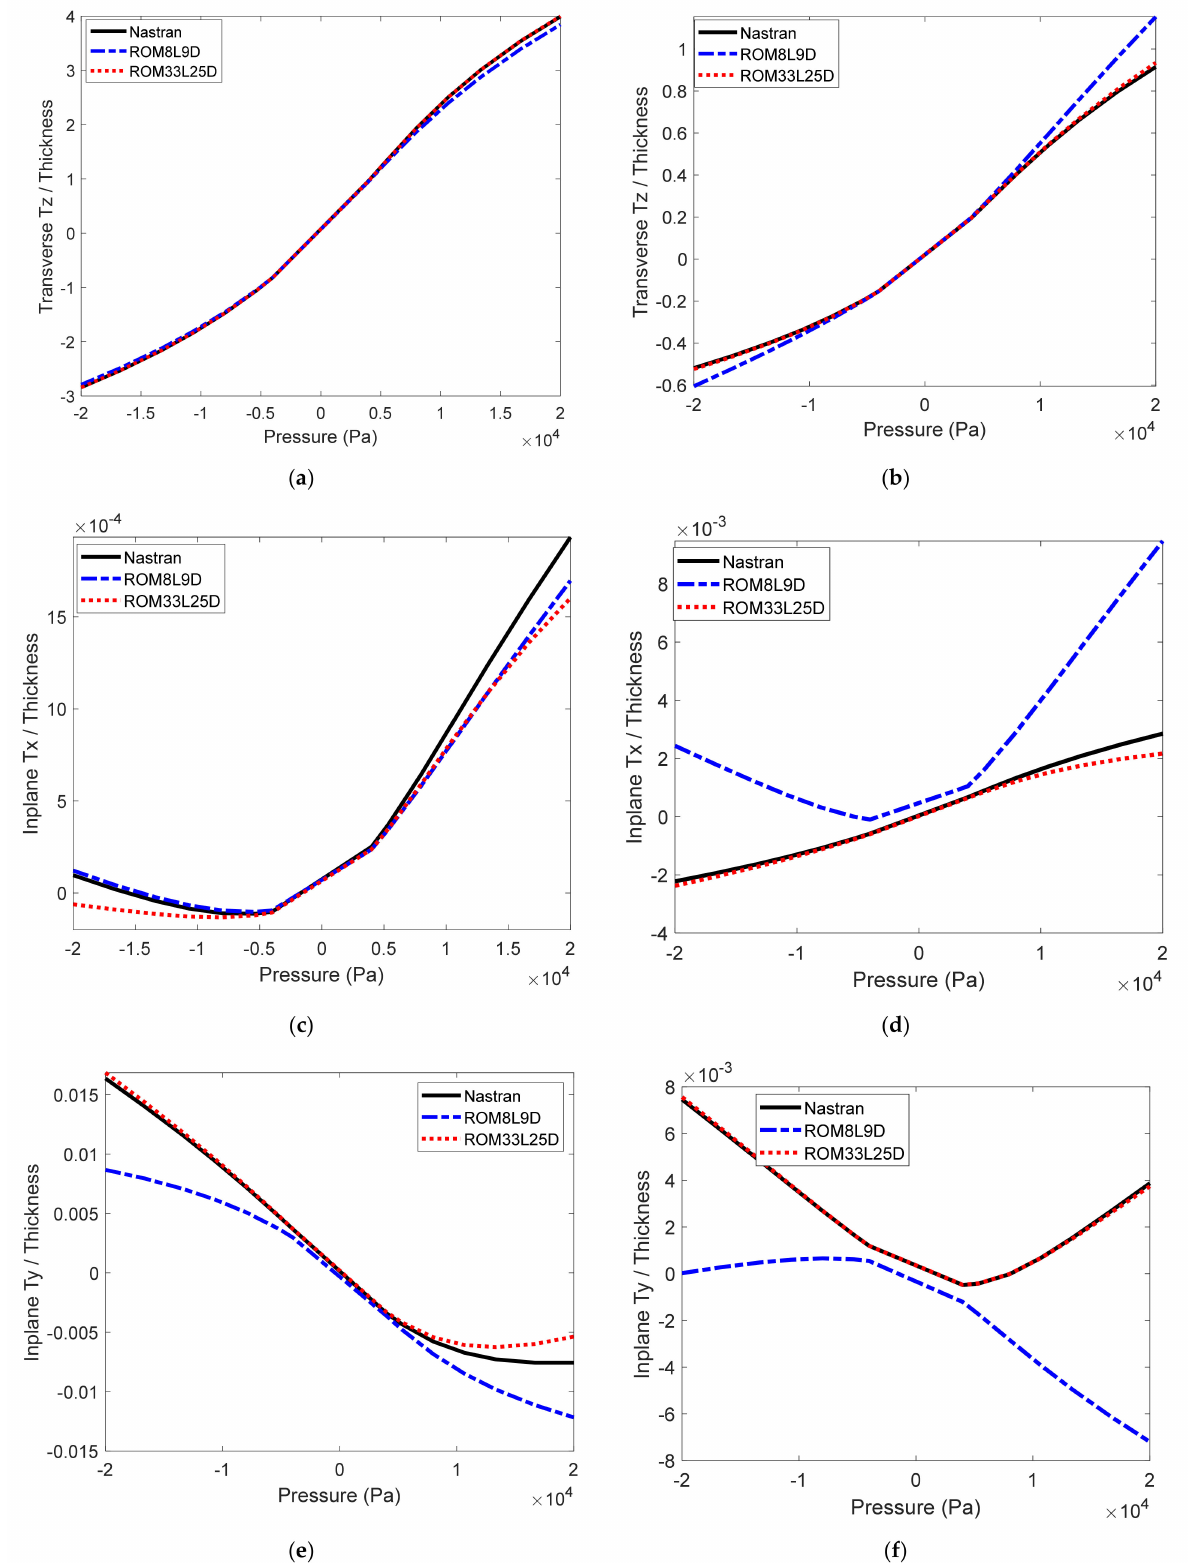
Figure 15. Static displacements induced by a fore-aft asymmetric pressure on the orthogrid panel. Predictions from Nastran and the 8L9D and 33L25D ROMs. ( a , c , e ) center point, ( b , d , f ) quarter point, displacements along ( a , b ) transverse z , ( c , d ) in-plane x , ( e , f ) in-plane y